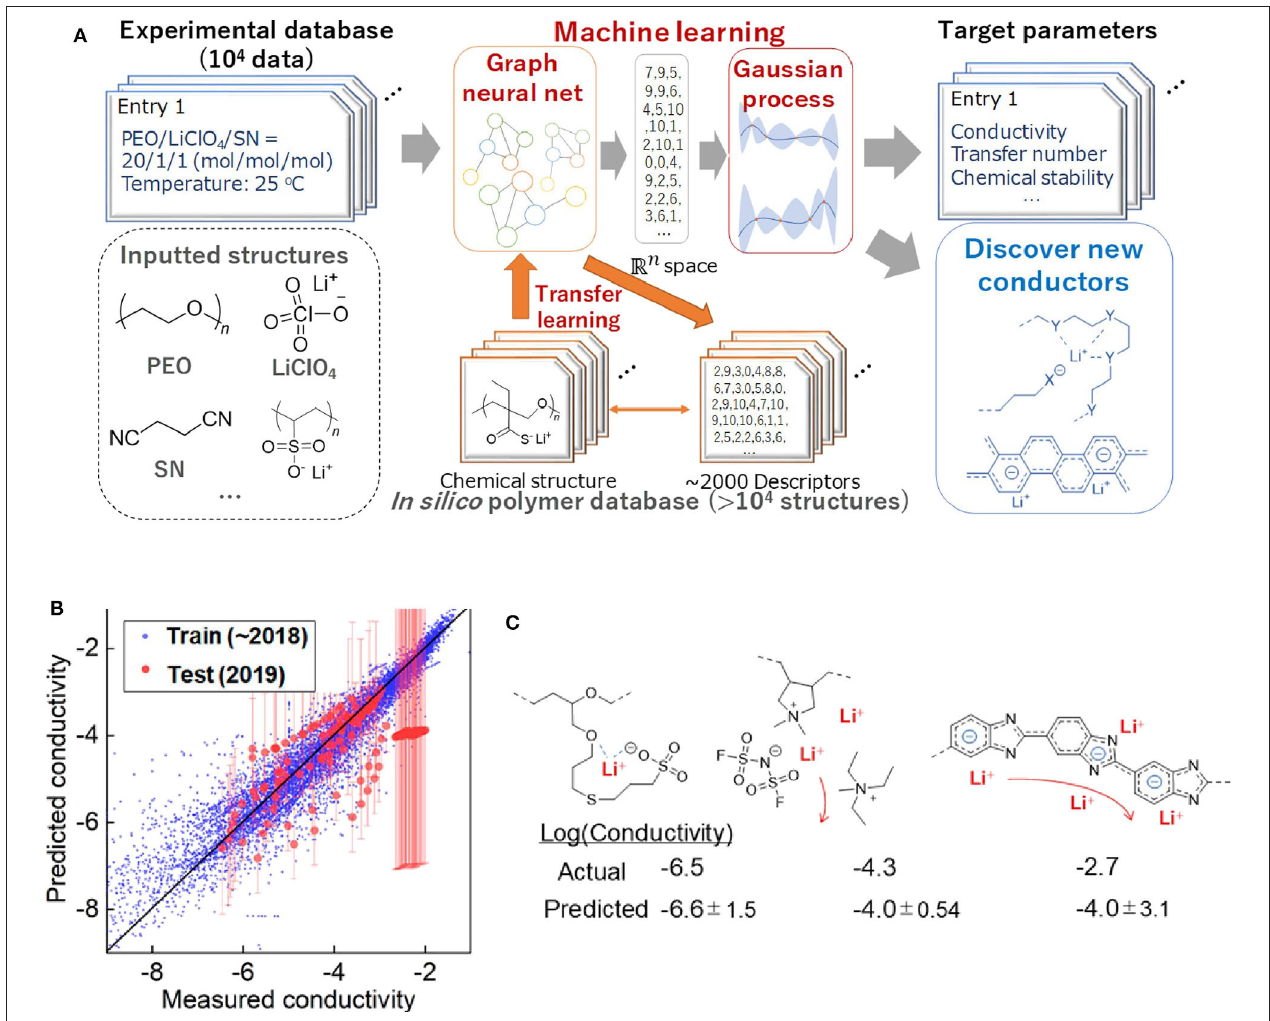
FIGURE 6 | (A) Scheme for using AI to predict the conductivity of the solid polymer electrolytes in this study. (B) Relationship between the measured and predicted conductivity (original units of S/cm, log scale). Training data contained liquids, plasticized/gelled conductors, and solid-state conductors. R 2 scores were 0.16 and 0.90 for test and training datasets, respectively. Excluding a polybenzimidazole electrolyte with a conductivity of about − 2, the test score would become 0.37. (C) Recently reported polymer-based conductors with example structures and room-temperature conductivity. Reprinted with permission from Hatakeyama-Sato et al. (2020). Copyright (2020) American Chemical